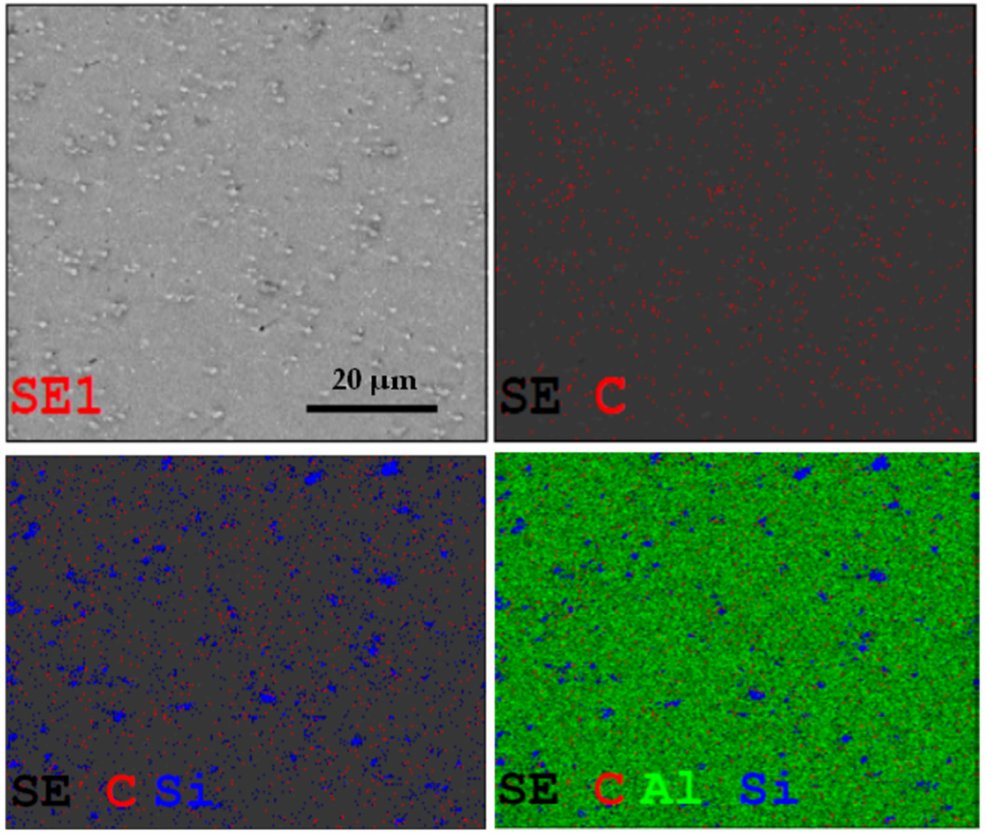
Figure 7. SEM and EDS mapping analysis of Al-4%SiC nanocomposite sheets after five ARB